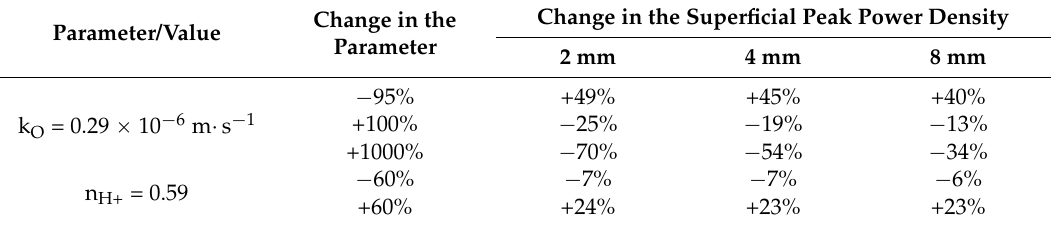
Table 2. Percentage change in the superficial peak power density of the FPMFCs with one at a time change of the characteristics of Nafion ® 117.